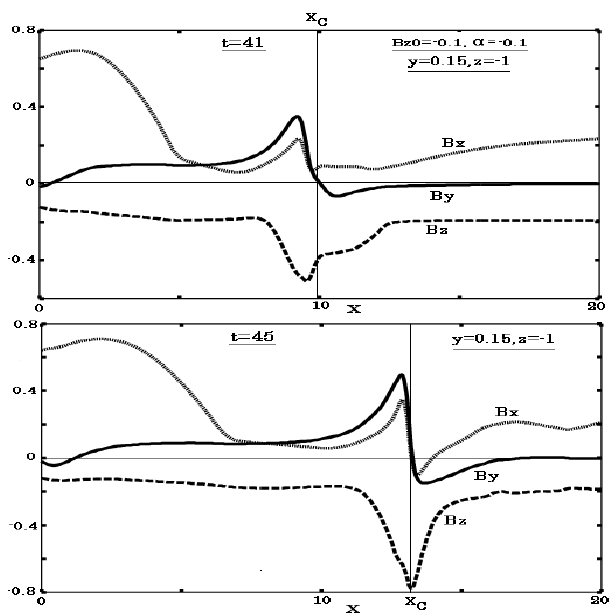
Fig. 9. x-directional profiles of magnetic field components B x ,B y and B z at y = 0 . 15 and z = − 1 . 0 at times t = 41 and 45 for the case of B z 0 =− 0 . 1 and α =− 0 . 1, where the plasmoid center X C is indicated.